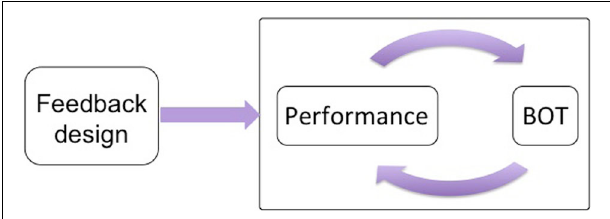
FIGURE 3 | Model diagram for effect of feedback design. Feedback bias can affect the interaction between BCI-performance and BOT